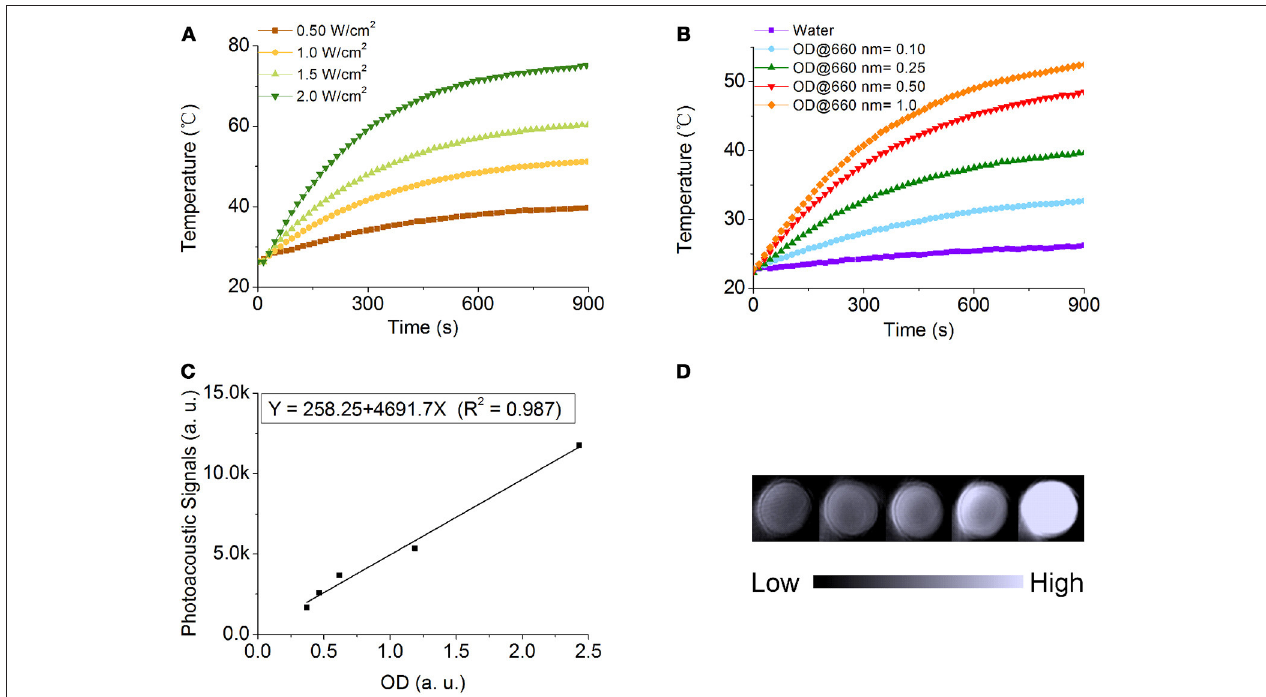
FIGURE 5 | Photothermal conversion and photoacoustic properties of NOPs. (A) Temperature variation of NOPs with the optical density at 660nm (OD 660nm ) of 1.0 irradiated at different laser power densities: 0.50 (brown), 1.0 (yellow), 1.5 (light green), and 2.0 W/cm 2 (dark green). (B) Temperature variation of NOPs with different OD 660nm values: 0.10 (blue), 0.25 (green), 0.50 (red), and 1.0 (orange) irradiated at a laser power density of 1.0 W/cm 2 . (C) Photoacoustic signals of NOPs as a function of OD 680nm . (D) Photoacoustic images of